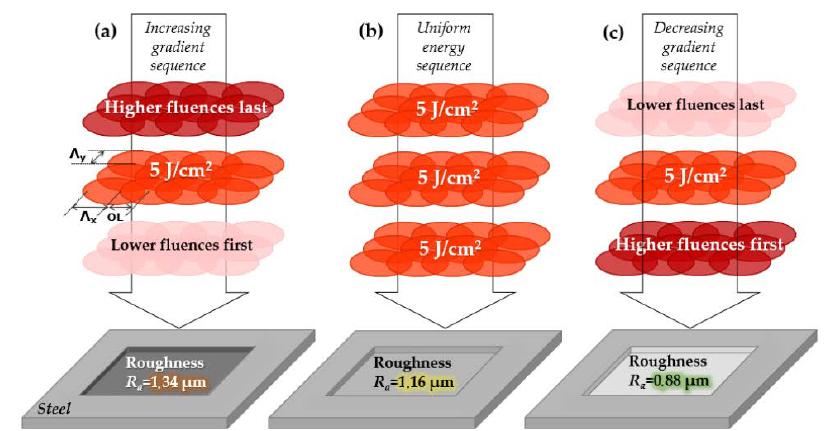
Figure 2. Schematic representation of the irradiation sequences consisting of 20 repetitions of the same scan pattern (only three are drawn for clarity) with ( a ) an increase in laser fluence between the scans starting with low fluences (0.5 J/cm 2 ) and ending with high fluences (9.5 J/cm 2 ), ( b ) constant fluence at 5 J/cm 2 and ( c ) a decrease in laser fluence starting with high fluences and ending with low fluences. The post-irradiation surface roughness for steel is indicated in each case showing a decrease of roughness from ( a ) to ( b ) and to ( c